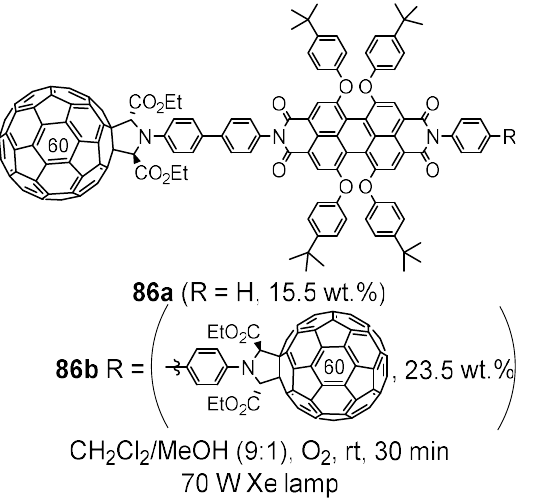
Figure 23. Results obtained in the aerobic oxidative dehydrogenation of 1,5-dihydroxynaphthalene to Juglone ( 85 : R 1 = R 2 = R 5 = H, R 4 = OH) catalyzed by 86 .